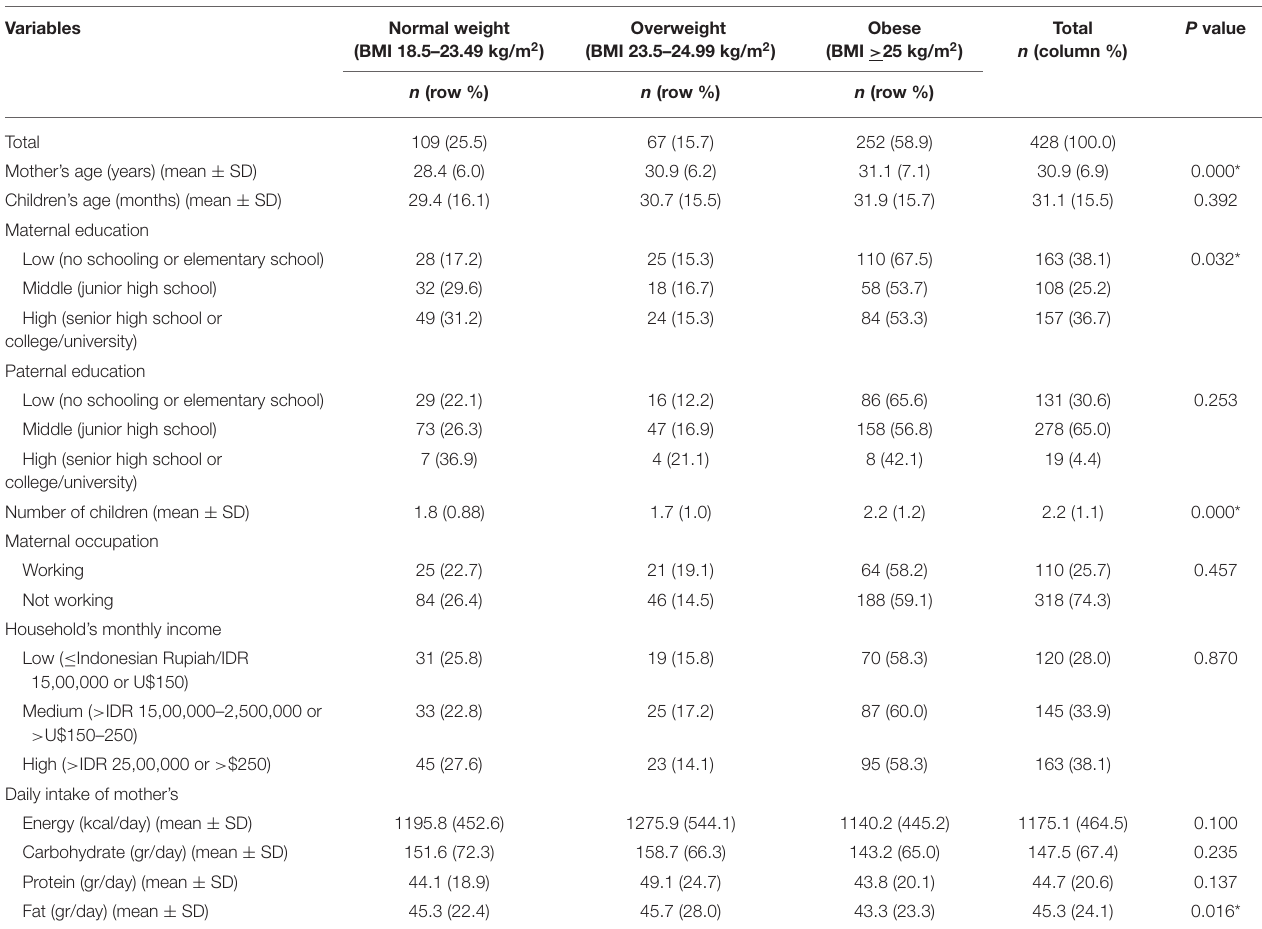
TABLE 1 | Socio-economic profile of household.